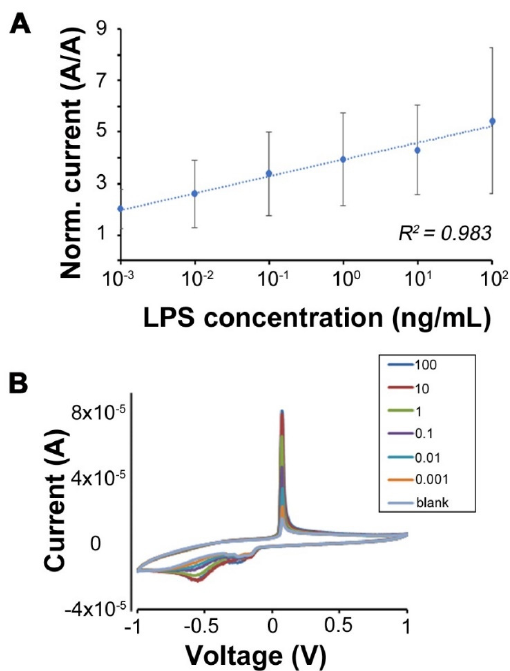
Figure 4. Analysis of Chi-AgNPs modified electrodes for LPS detection over 0.001–100 ng / mL. ( A ) calibration curve showing the linear response over six orders of magnitude in concentration. Here, the currents have been normalized to their value at 0 (blank). n = 3 different samples tested; error bars represent standard deviation for three independent experiments; ( B ) example CV showing the response to increasing LPS concentration.